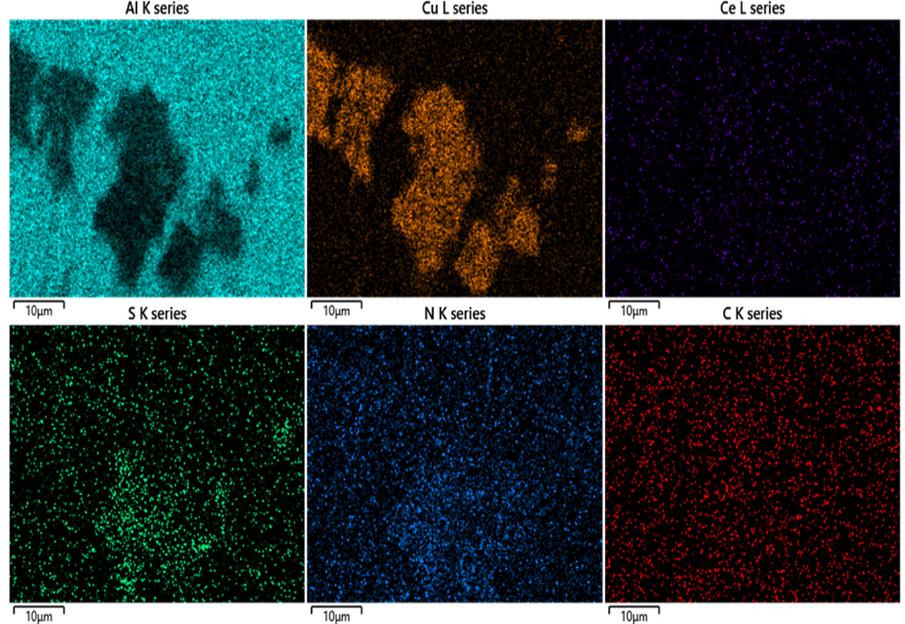
Figure 9. SEM-EDS mapping of the main element distribution in the AA 2024-T3 sample dipped in a 3.5% NaCl-containing inhibitor for 120 h.